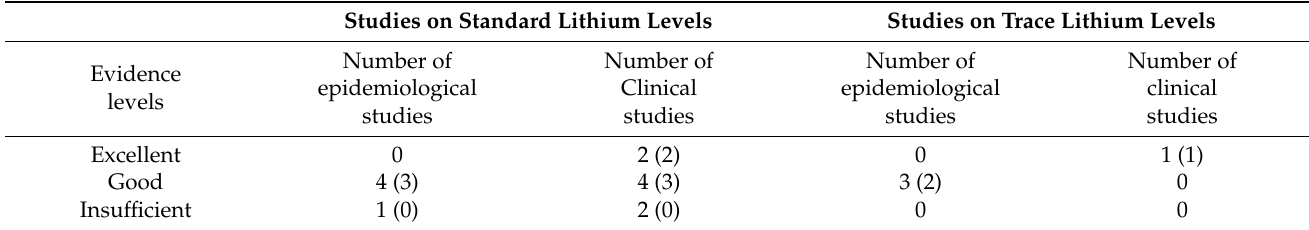
Table 1. Number of epidemiological or clinical studies of standard lithium levels or trace levels on dementia